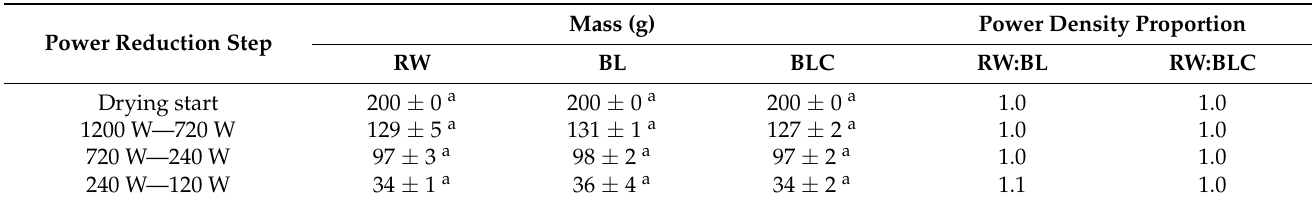
Table 1. Mass (g) of samples and power density proportion between the drying process of each sample (RW, BL, and BLC) during each power reduction step.